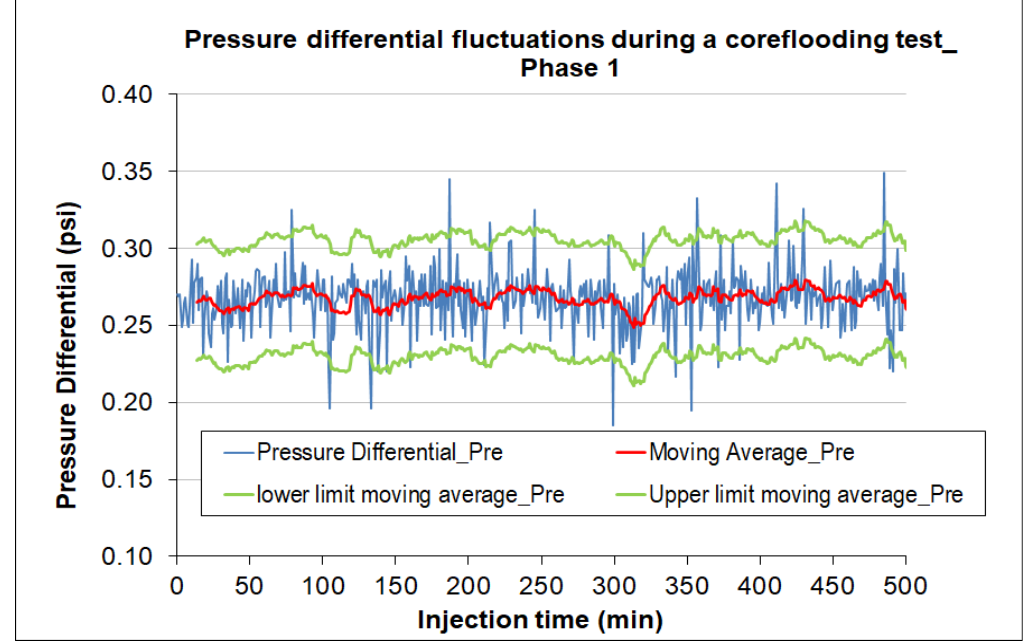
Figure 6: Confidence level (95%), for the pressure differential measurements. Source: Authors,